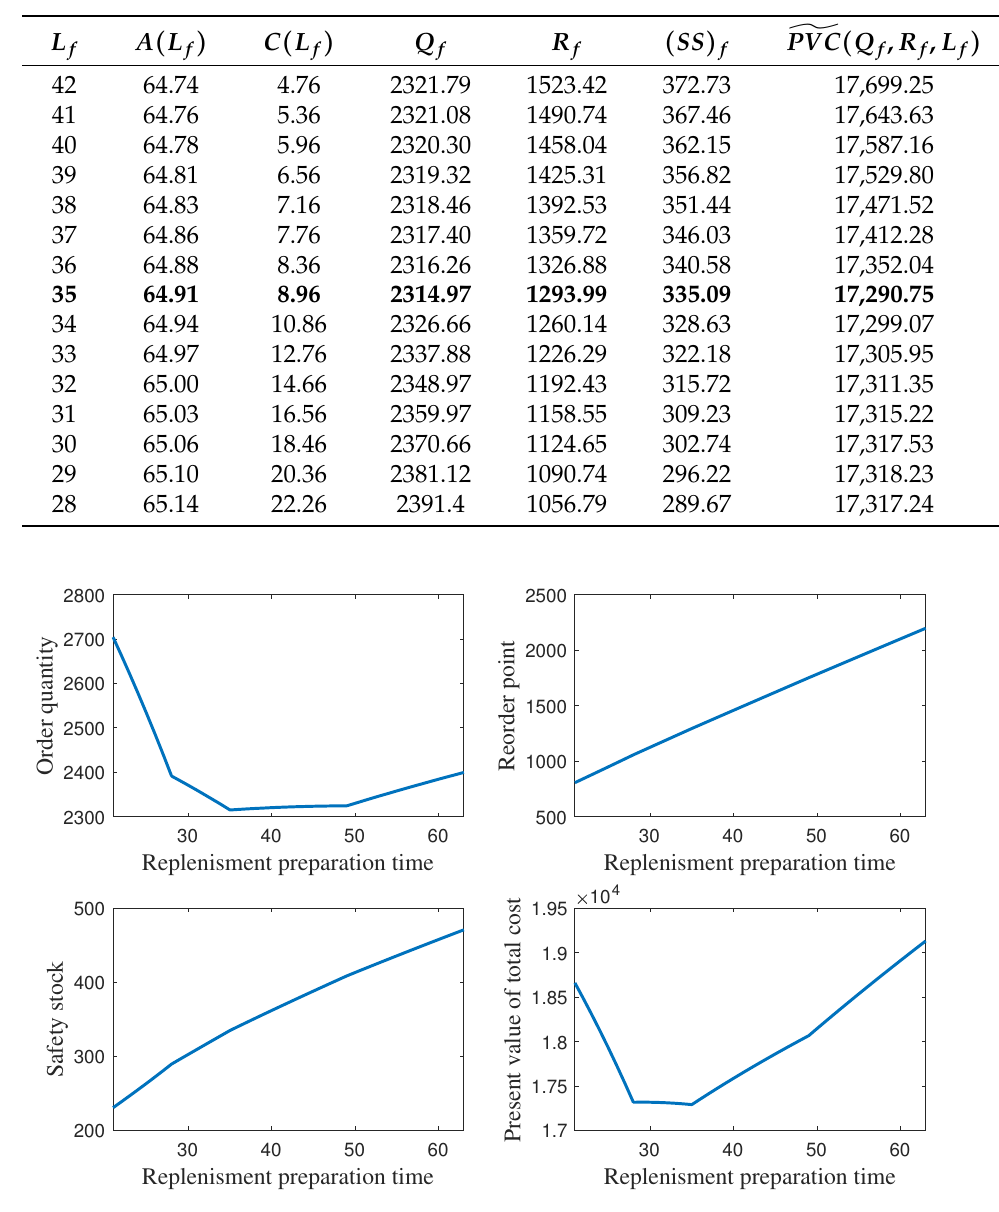
Figure 9. Plots of Q , R , SS , and PVC ( Q , R , L ) under different L